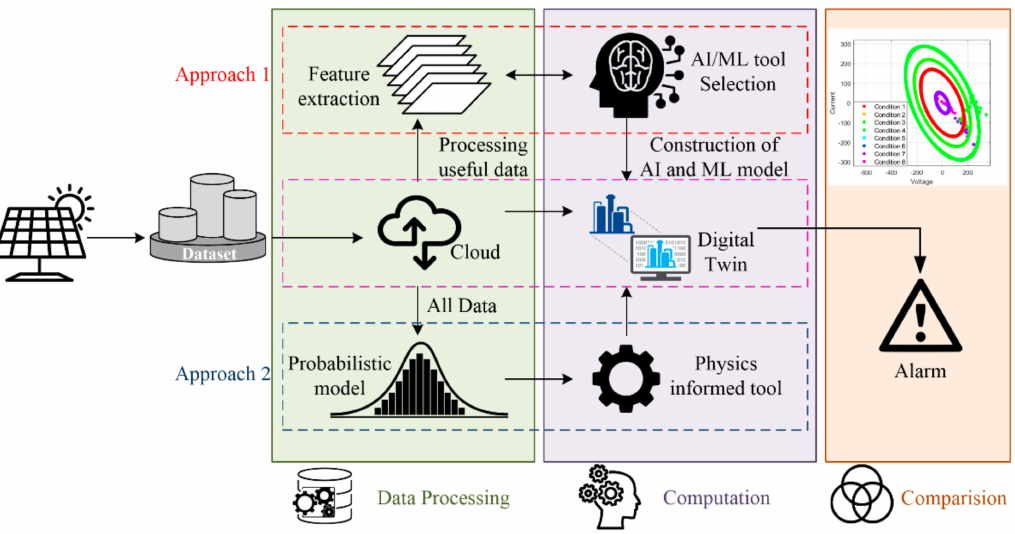
Figure 15. Digital twin framework of a physical